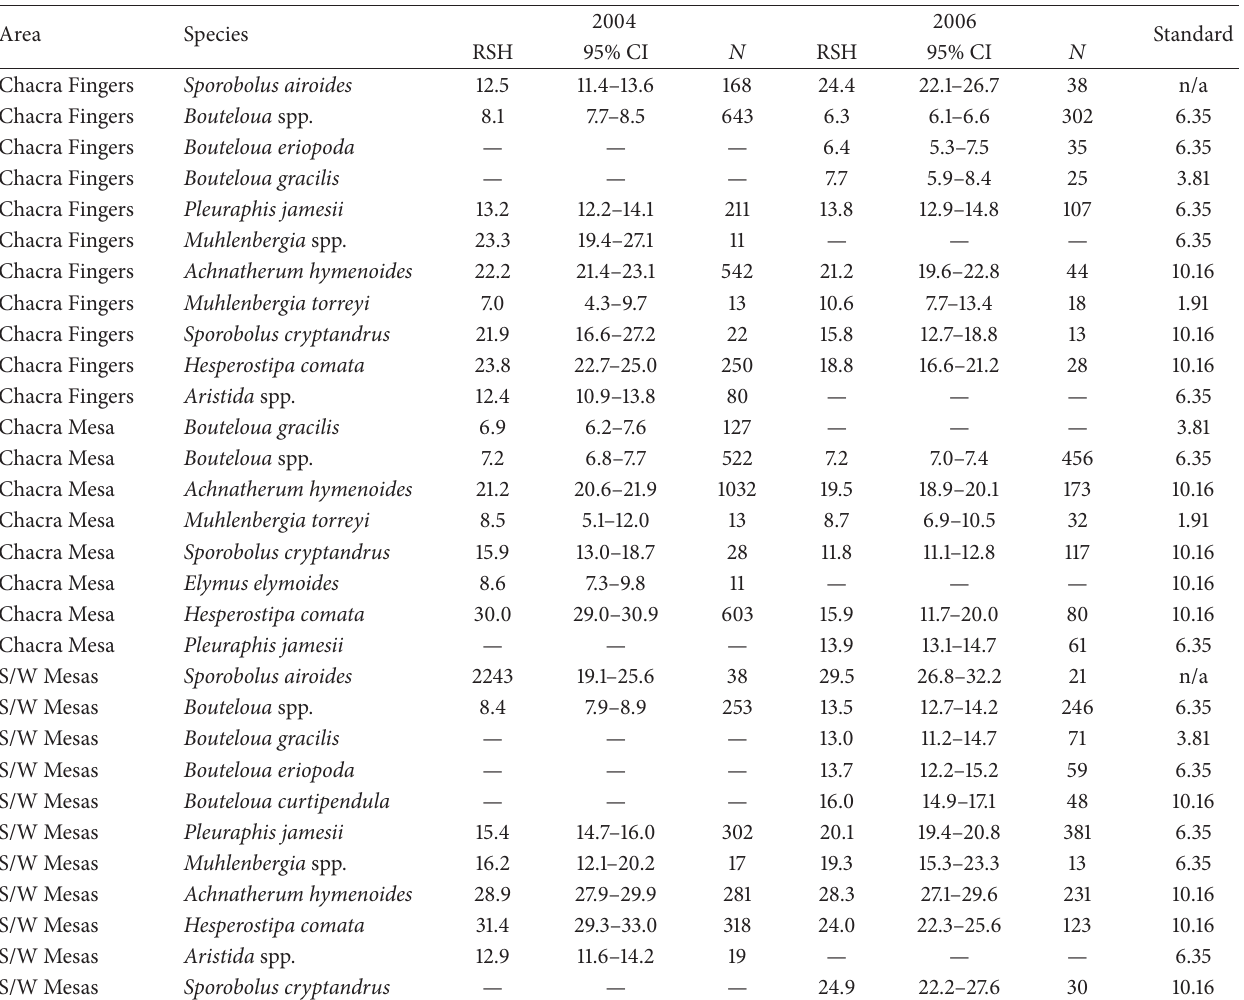
Table 5: Species, number of plants per species, and mean residual leaf stubble height (cm) with 95% confidence interval for grasses detected on grazing surveys, Chaco Culture National Historical Park, 2004 and 2006. The cutoff height below which a plant is considered “overgrazed,” as defined by Allison et al. (2007) [25], is given (Standard). Area